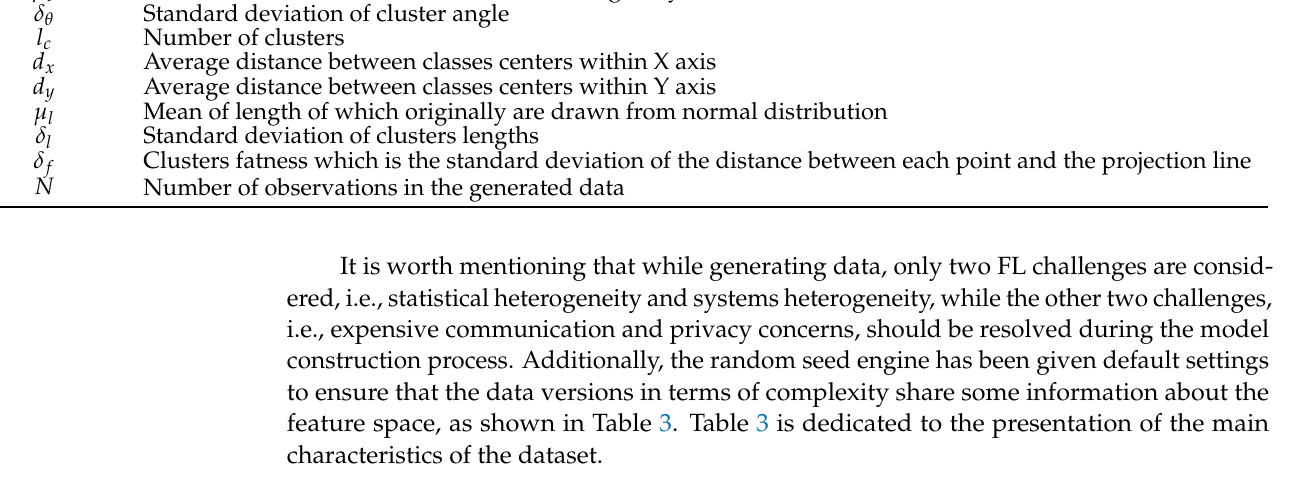
Table 3. Tuned parameters for dataset